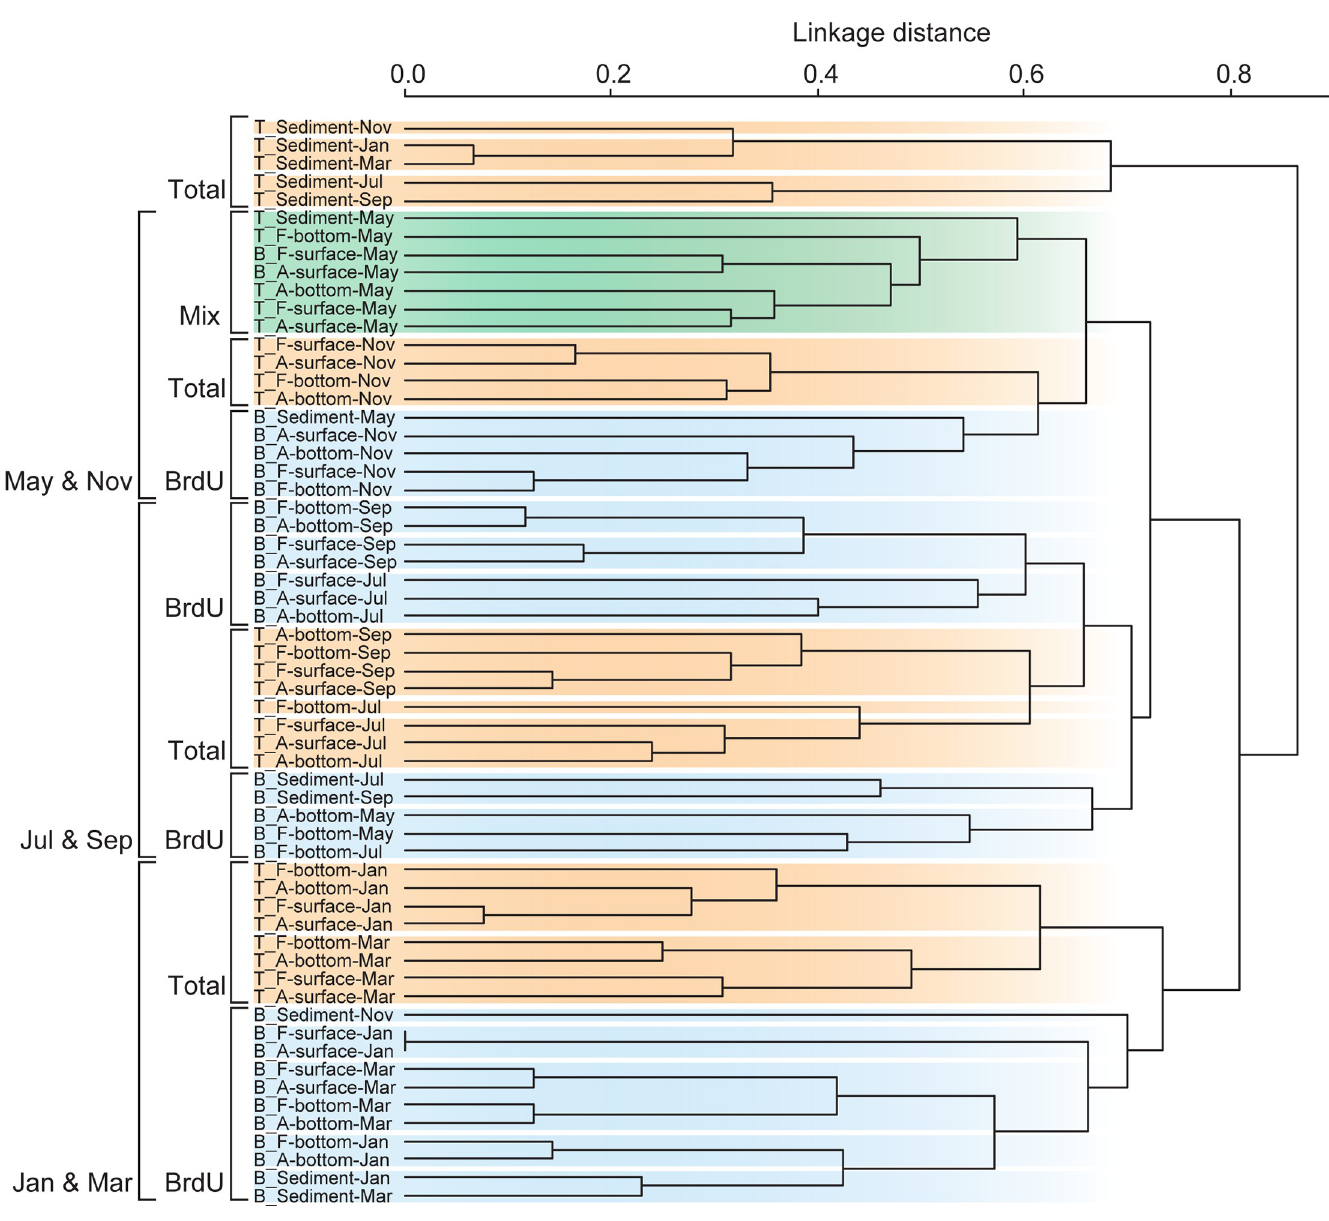
Fig 3. Relationships among community structures of total and BrdU-incorporating bacteria from the aquaculture environment in the indicated months. Each colored box (Orange: total community cluster, Blue: BrdU-incorporating community cluster, Green: total and BrdU-incorporating communities cluster) indicates distinguishable clusters (SIMPROF, p < 0.05). T: total community, B: BrdU-incorporating community, F: free-living bacterial community, A: particle-attached bacterial community.